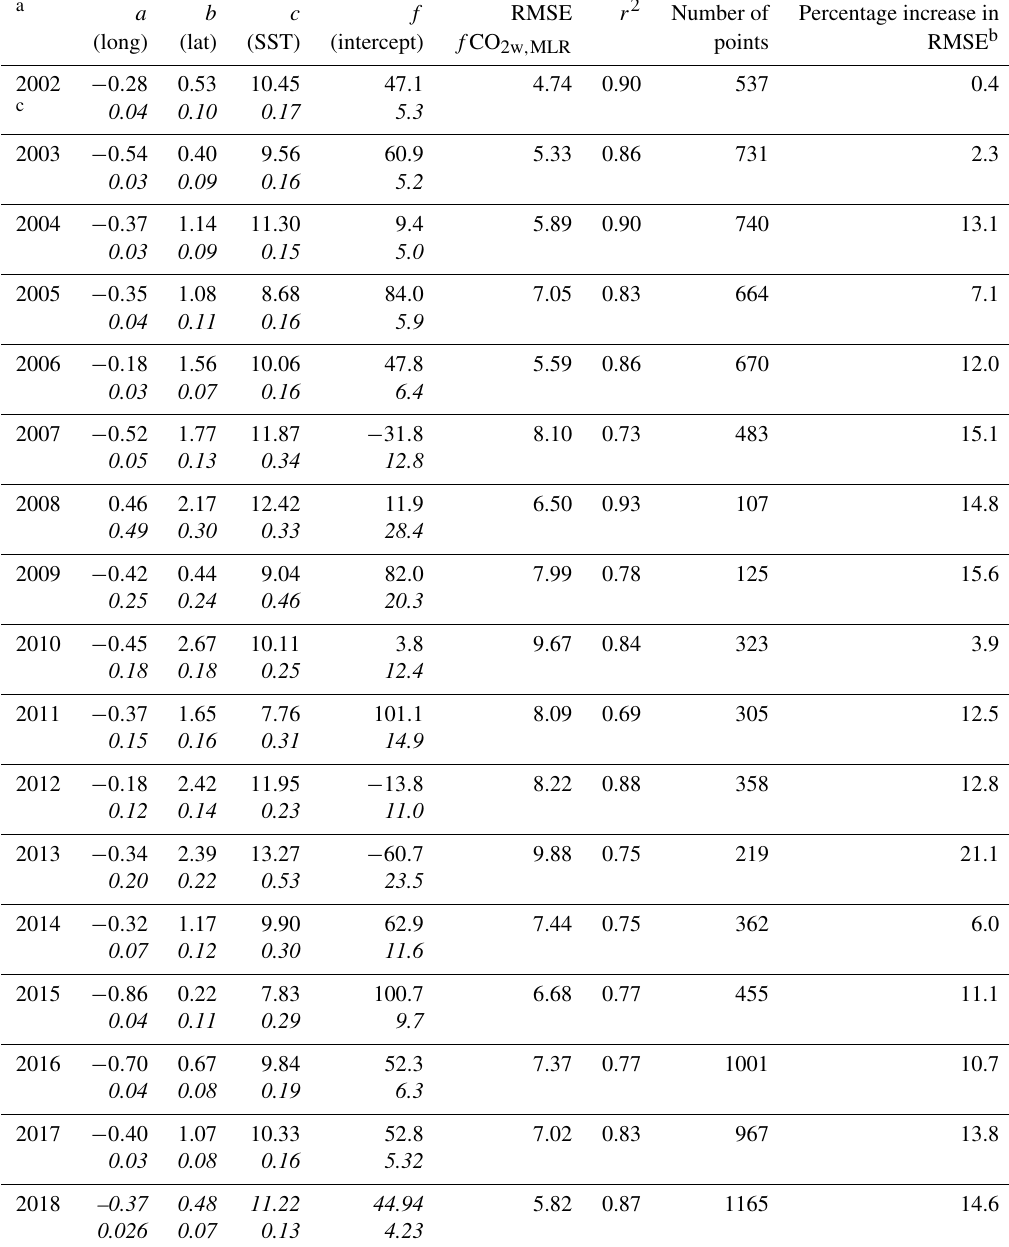
Table A2. Coefficients for the MLR, f CO 2w , MLR = a long + b lat + c SST + f